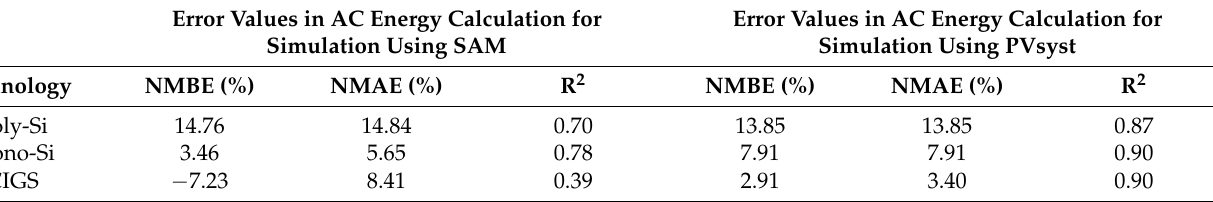
Figure 17. Comparison of actual energy generated and performance ratio to simulated values for CIGS array. Table 5. Error values of simulation using SAM and PVsyst. Error Values in AC Energy Calculation